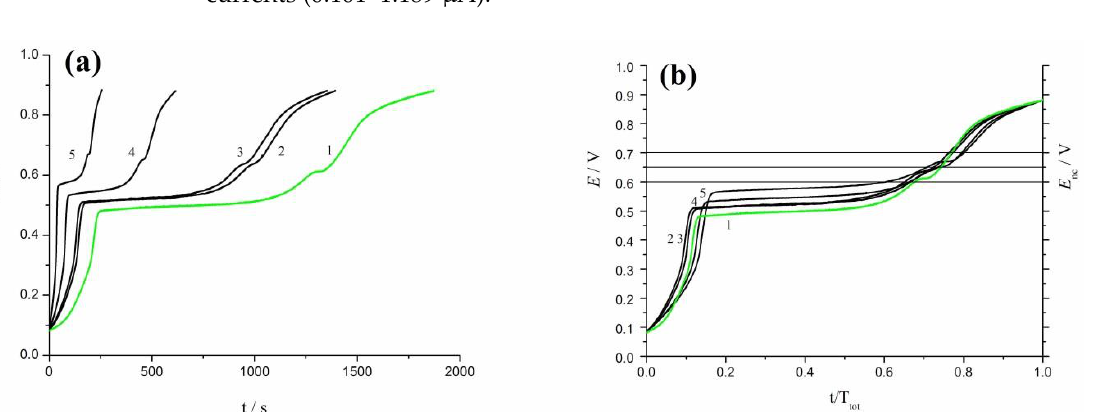
Figure 7. ( a ) Transient of non-current potential (green lines) (1) and galvanostatic potentiometric curves (black lines) at set DC ( µ A): (2)—0.101; (3)—0.161; (4)—0.437; and, (5)—1.189, in water saturated with CO 2 solution after rCO 2 accumulation at E = 0.08 V. ( b ) Corrected transients of non-current potential (green line) (1) and galvanostatic potentiometric curves (black lines) at set DC ( µ A): (2)—0.101; (3)—0.161; (4)—0.437; and, (5)—1.189, in water saturated with CO 2 solution after rCO 2 accumulation at E = 0.08 V in E ,t/T tot scale.